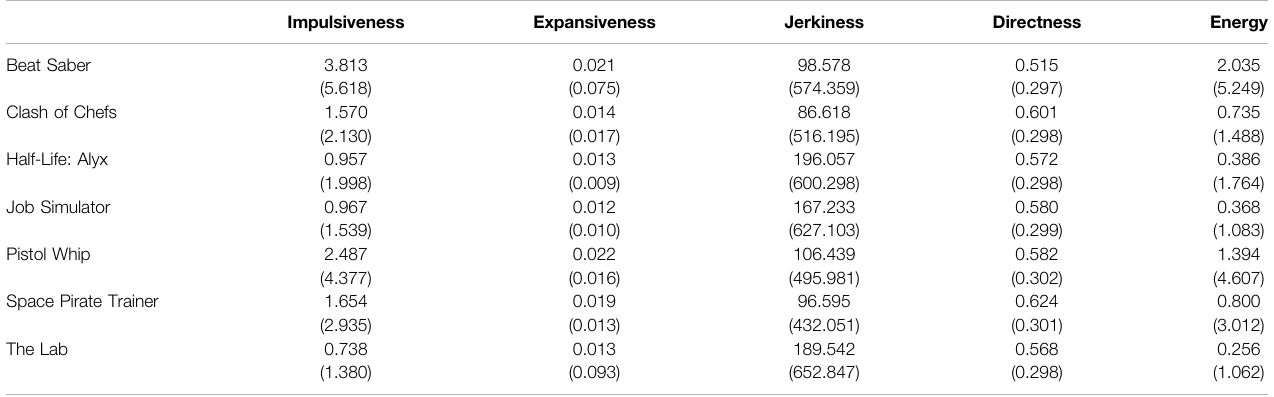
TABLE 1 | Computed mean values and standard deviations (in parentheses) for the hands by game. Values are rounded to three decimals.